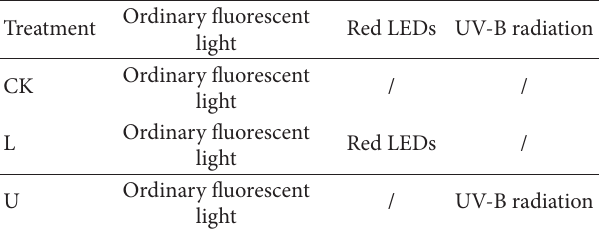
Table 1: The treatments of the experiment.